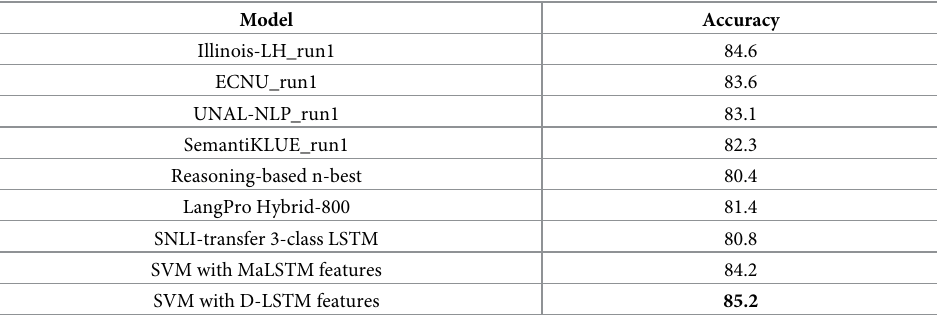
Table 3. Test set accuracy for the SICK semantic entailment